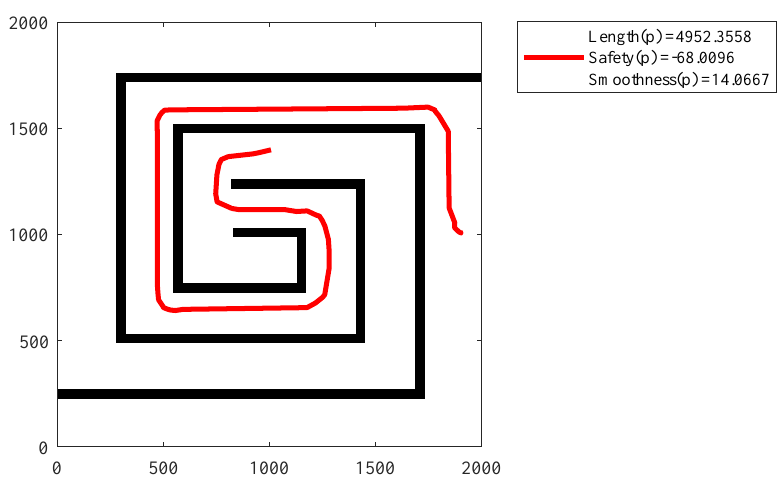
Figure 16. Graphical solution for the Figure 8C with MOEA.